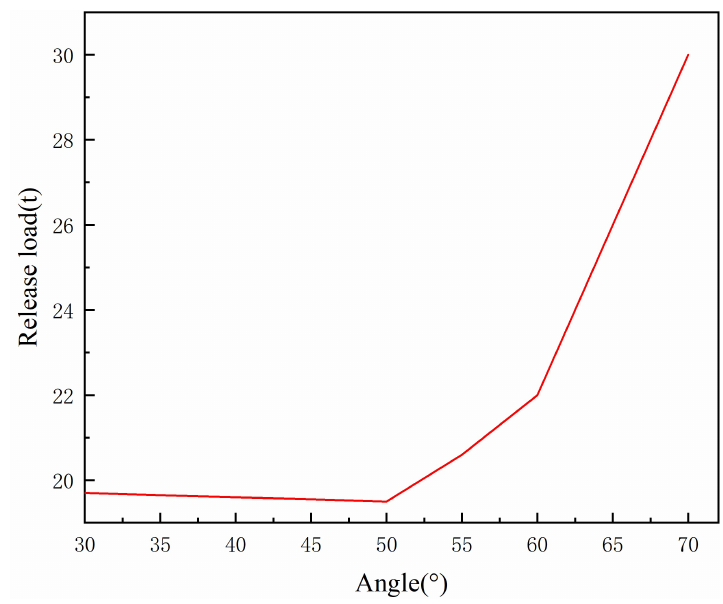
Figure 10. Release load at different angles.